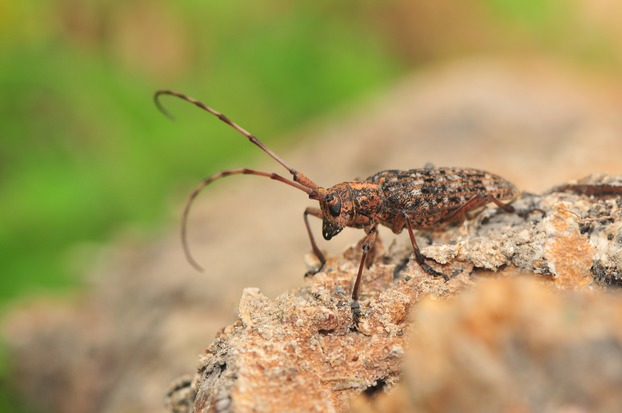
Pine sawyer beetle (Monochamus alternatus Hope) is one of the most important vector of pine wood nematode in China.